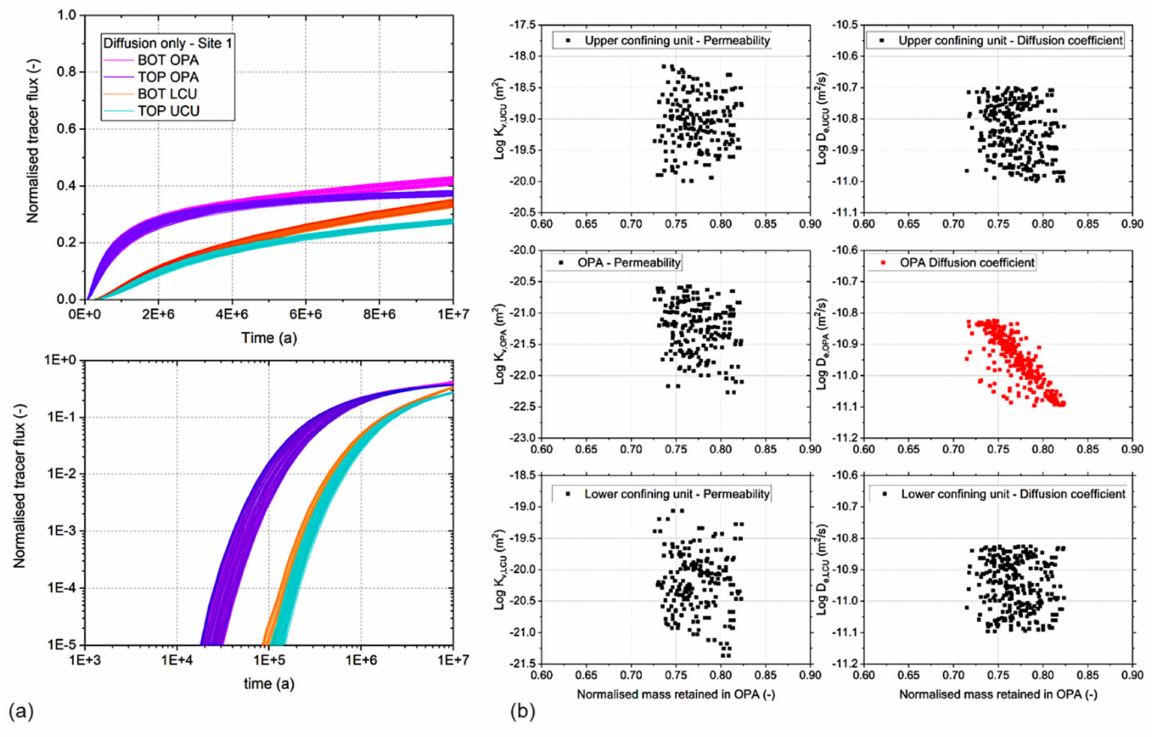
Figure 15. Delineation of the Effective Confinement Zone : ( a ) simulated tracer breakthrough at top and bottom of the host rock and upper/lower confining units; ( b ) correlations between retained mass in host rock and perturbed